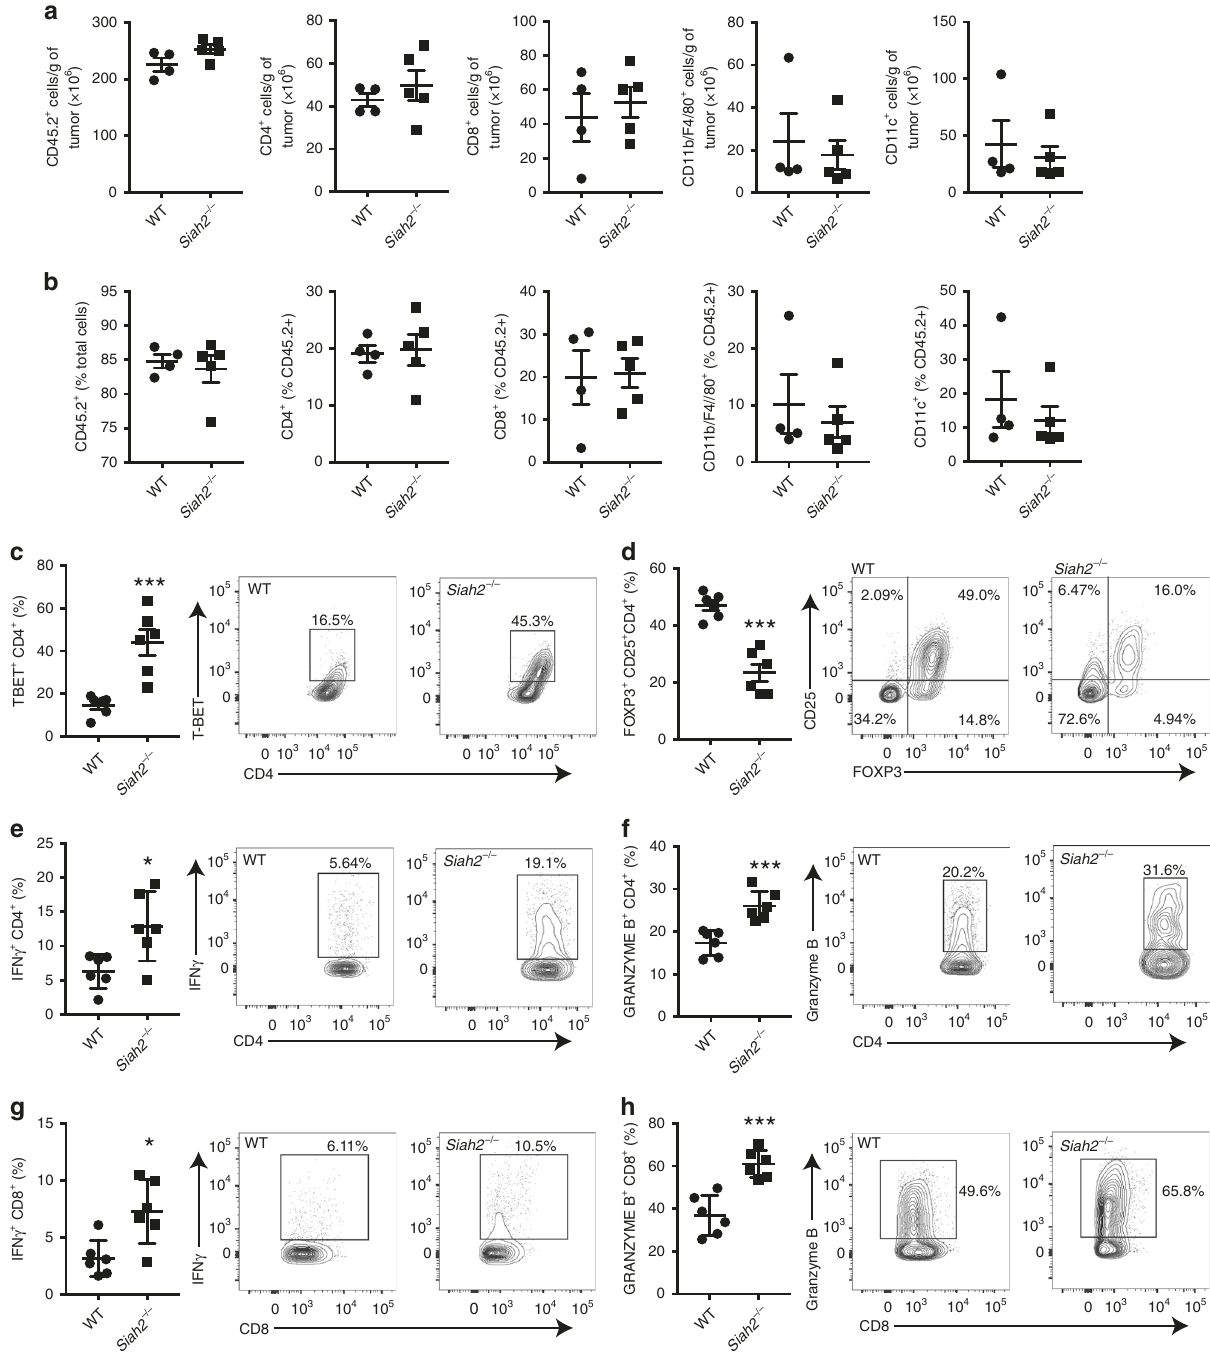
Fig. 2 Altered intratumoral effector T cells and Tregs in Siah2 − / − mice. a , b Quanti fi cation of tumor-in fi ltrating immune cells (CD45.2 + ), CD4 + and CD8 + T cells, CD11b + /F4/80 + , and CD11c + cells on day 11 after YUMMER1.7 cell injection. Quanti fi cation is reported as total number/g tumor a , and as percentage b of indicated immune cells among total cells (for the graph in b analyzing frequency of CD45.2 + ), or CD45.2 + cells (for other graphs in b ; n = 4 for WT; n = 5 for KO). c , d Percentage of tumor-in fi ltrating T-bet + c and FOXP3 + d cells within the CD4 + T cell population at day 11 after tumor inoculation ( n = 5 for WT; n = 6 for Siah2 − / − ). e – h Frequencies of tumor-in fi ltrating IFN- γ - and granzyme B-expressing CD4 + e , f or CD8 + g , h T cells 11 days after tumor cell inoculation and following stimulation overnight in vitro with melanoma peptides ( n = 6) e – h ; mean ± s.e.m. Data were analyzed by unpaired t -test. *** P < 0.0005, ** P < 0.005, and * P < 0.05 compared with